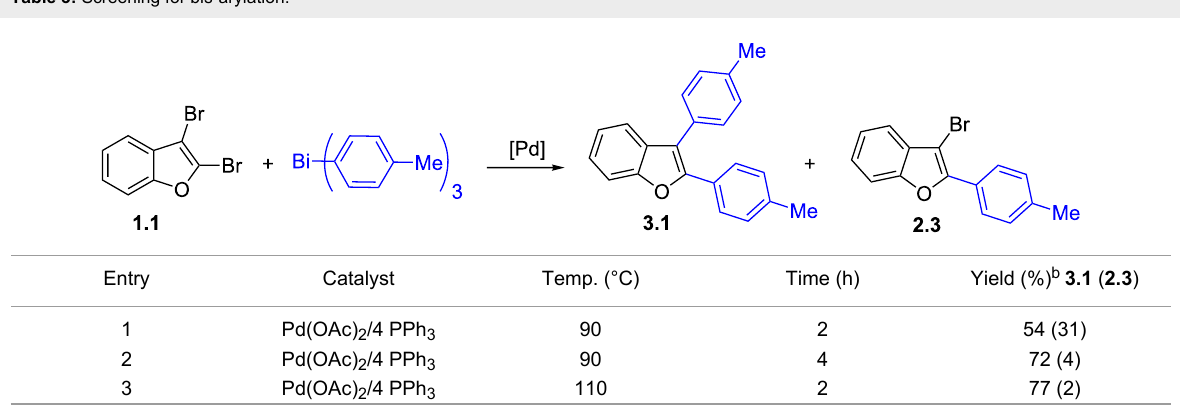
Table 3: Screening for bis-arylation.